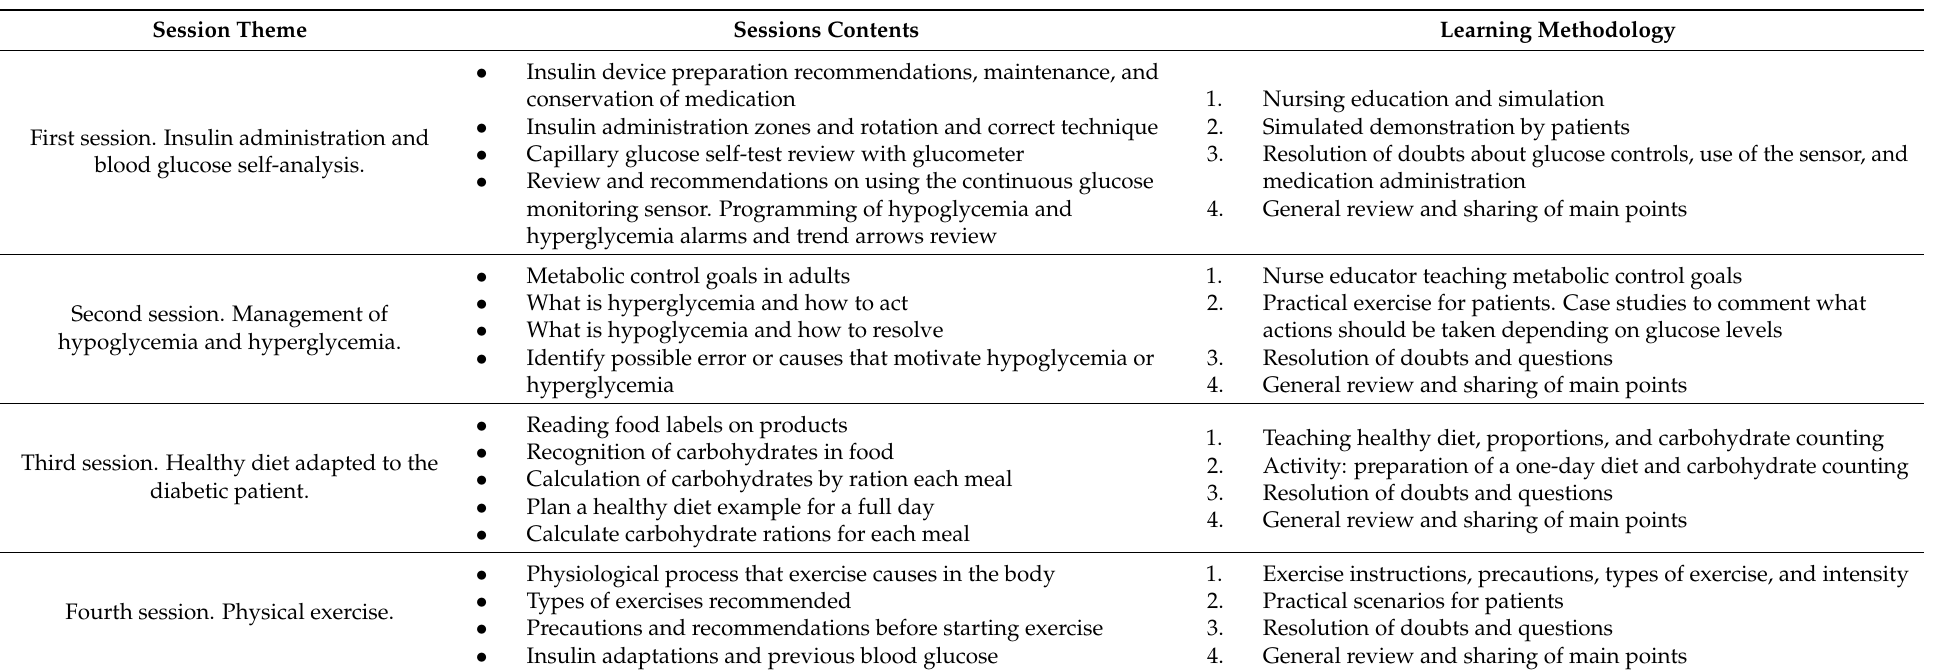
Table 1. Structured education